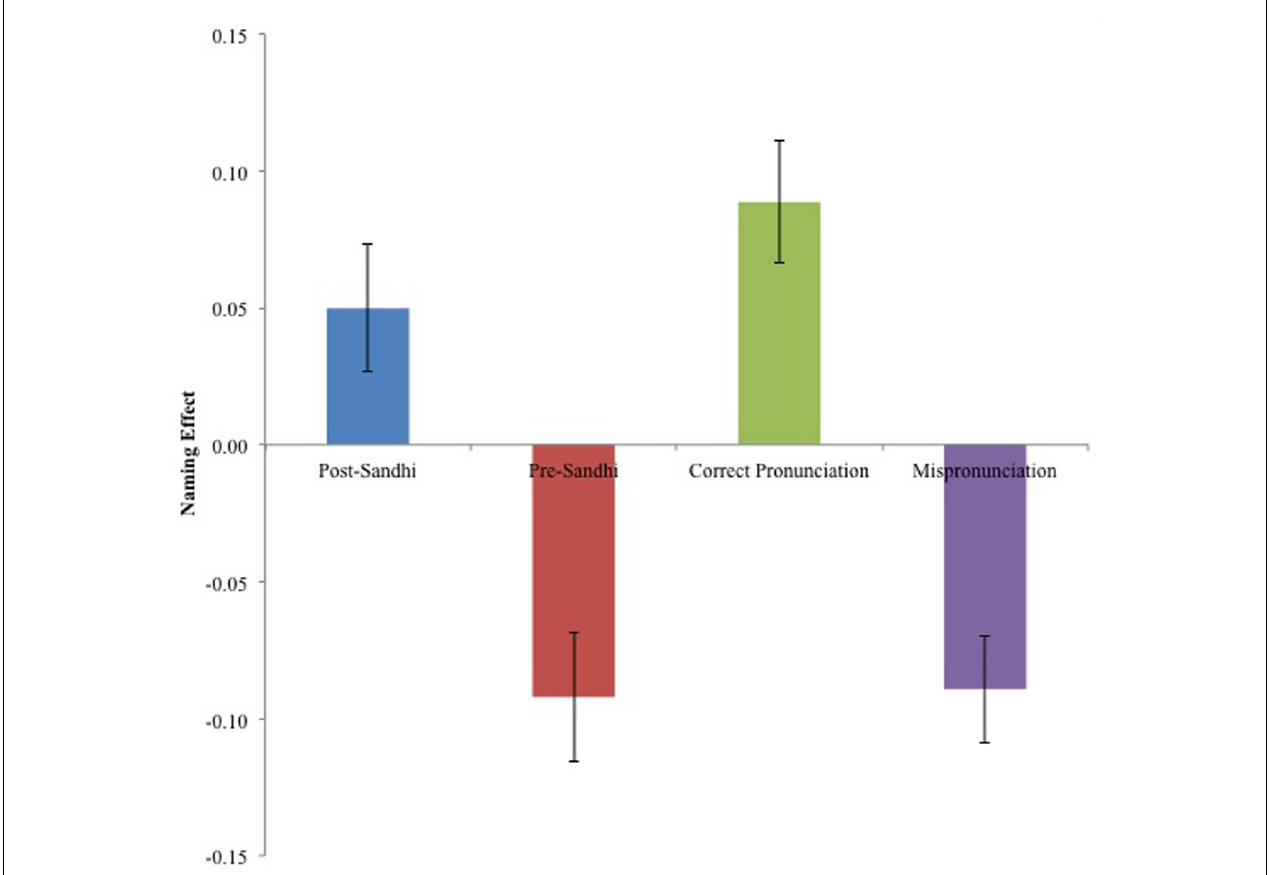
FIGURE 3 | Naming effects of post-Sandhi, pre-Sandhi, correct, and mispronounced forms (Error bars reflect SEM).